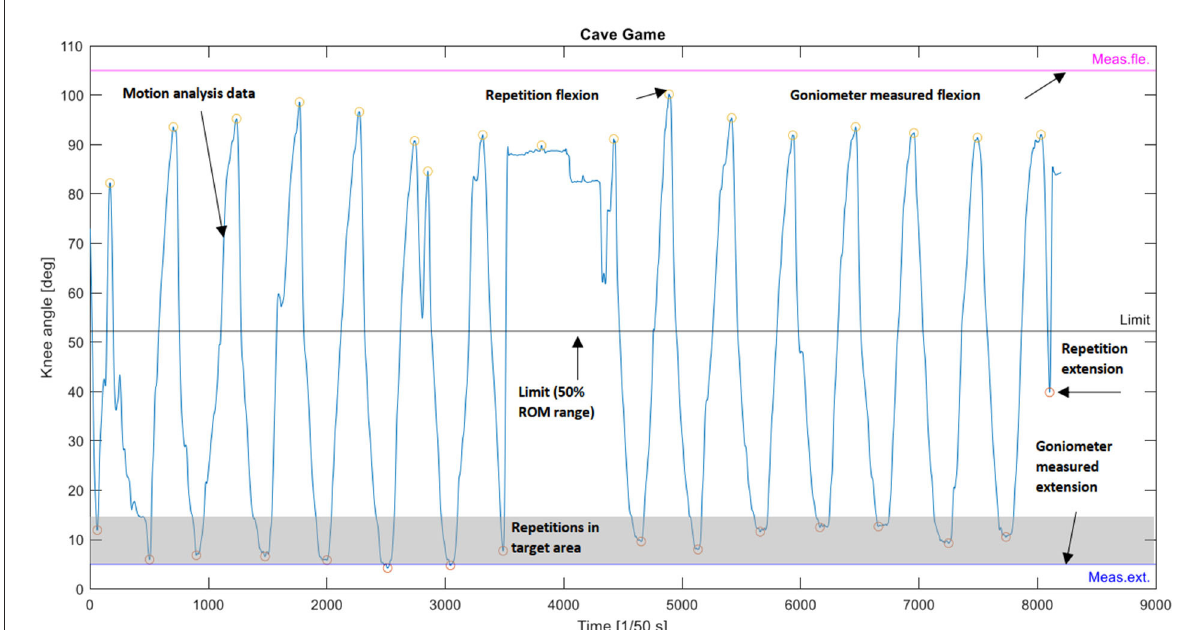
FIGURE1 Identification of repetitions from the motion analysis data of the knee extension-flexion exergame (the Cave Game) where knee extension was the primary movement goal.